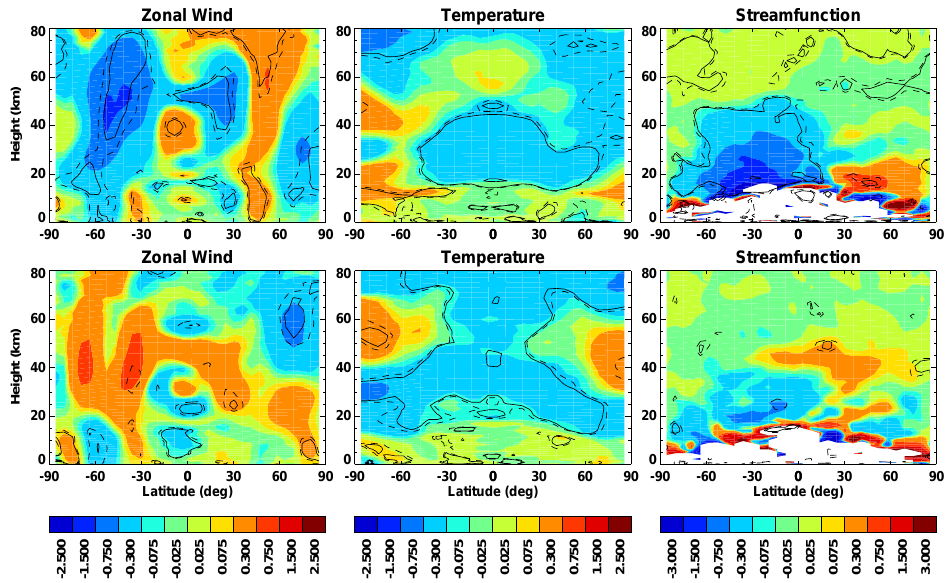
Fig. 16. Comparison of run mean, ensemble mean, annual mean difference from the reference ensembles of zonal wind (left, ms − 1 ), temperature (middle, K) and mass streamfunction (right, kgm − 1 s − 1 ). Top panels are for solar variability with EPP ensemble vs. solar variability only ensemble. Bottom panels are for the Sect. 4 ensembles without the solar cycle in irradiance: the combined EPP ensemble vs. the reference ensemble.